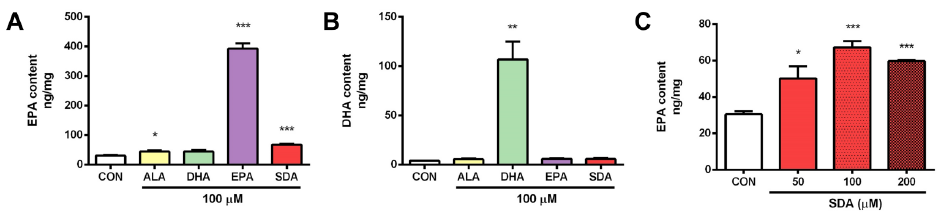
Figure 2. SDA effectively converted to EPA in rat hippocampal cells. H19-7 hippocampal cells were treated with ALA, DHA, EPA, SDA, or BSA–ethanol vehicle for 48 h. ( A ) EPA enrichment by ethanol vehicle control or 100 µ M of ALA, SDA, EPA, and DHA in H19-7 hippocampal cells. ( B ) DHA enrichment by ethanol vehicle control or 100 µ M of ALA, SDA, EPA, and DHA in H19-7 hippocampal cells. ( C ) EPA enrichment by SDA (0, 50, 100, and 200 µ M) in H19-7 hippocampal cells. Values were obtained from three independent experiments and were expressed as the means ± SEM. Data were normalized to the protein contents; * p < 0.05, ** p < 0.01, *** p < 0.001, different from BSA–ethanol vehicle-treated control